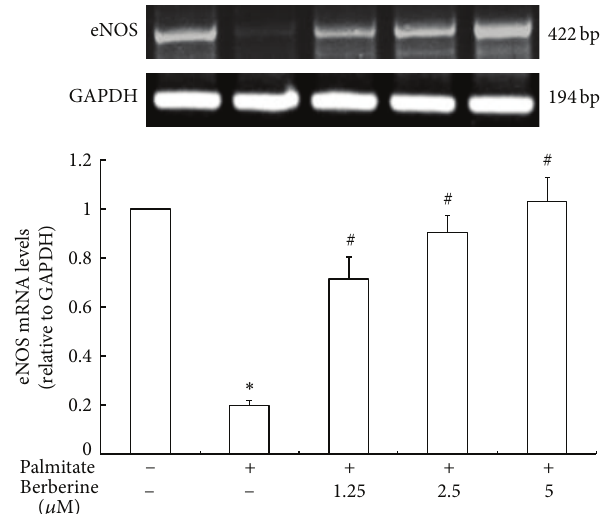
Figure 4: The effects of berberine on eNOS mRNA expression in HUVECs exposed to palmitate. HUVECs were cultured in RPMI- 1640 containing 0.5 mmol/L palmitate and treated with 1.25, 2.5, and 5 𝜇 mol/L berberine for 24 h. Total RNA was extracted and RT-PCR was performed. All values were normalized to 100% for the value of the control and were expressed as the percentage of the control. Data are mean ± S.E.M. The control group was not stimulated with 0.5 mmol/L palmitate. All presented results are representative of at least 3 independent experiments. ∗ 𝑃 < 0.05 versus control group. # 𝑃 < 0.05 versus palmitate treated